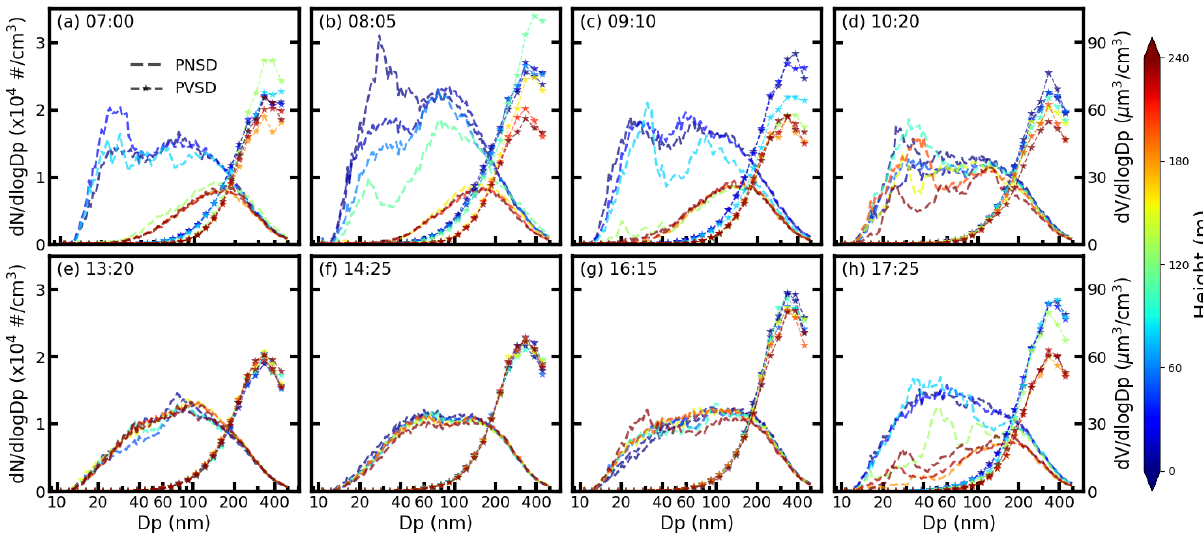
Figure 2. The measured aerosol PSND (dashed line) and the PVSD (dashed line with star) at (a) 07:00, (b) 08:05, (c) 09:50, (d) 10:20, (e) 13:20, (f) 14:25, (g) 16:15, and (h) 17:25. The filled colors represent the corresponding measurement altitude above the ground. Table 1. The number ratio of nucleation mode to Aitken mode.